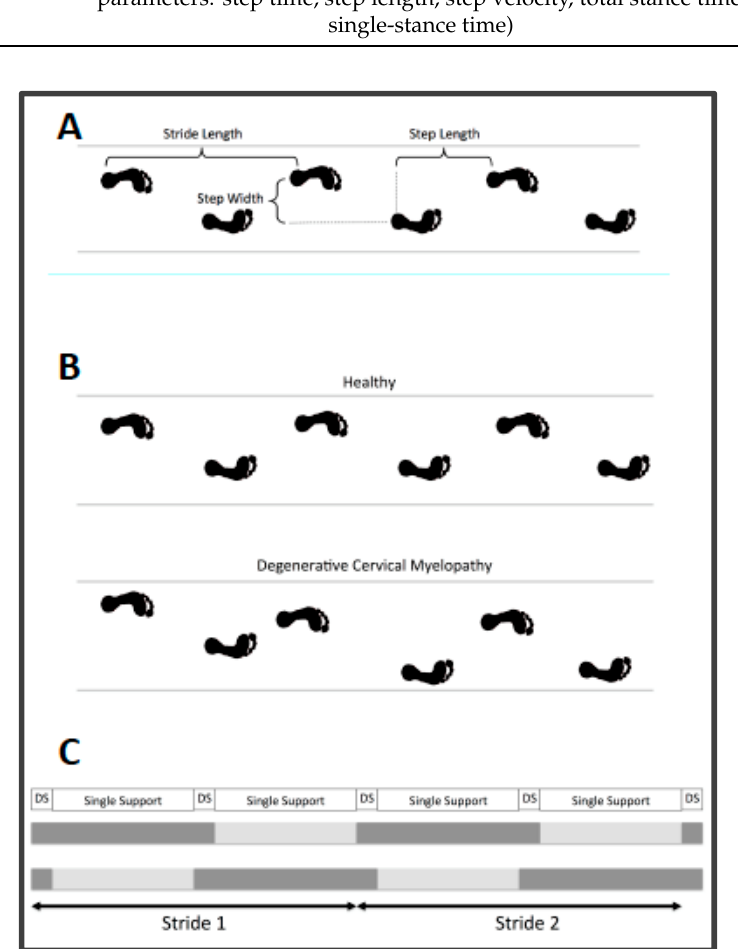
Figure 1. Visualization of spatial gait parameters ( A ). Visualization of gait variability in healthy subjects and increased variability in degenerative cervical myelopathy patients ( B ). Visualization of temporal gait parameters ( C ).